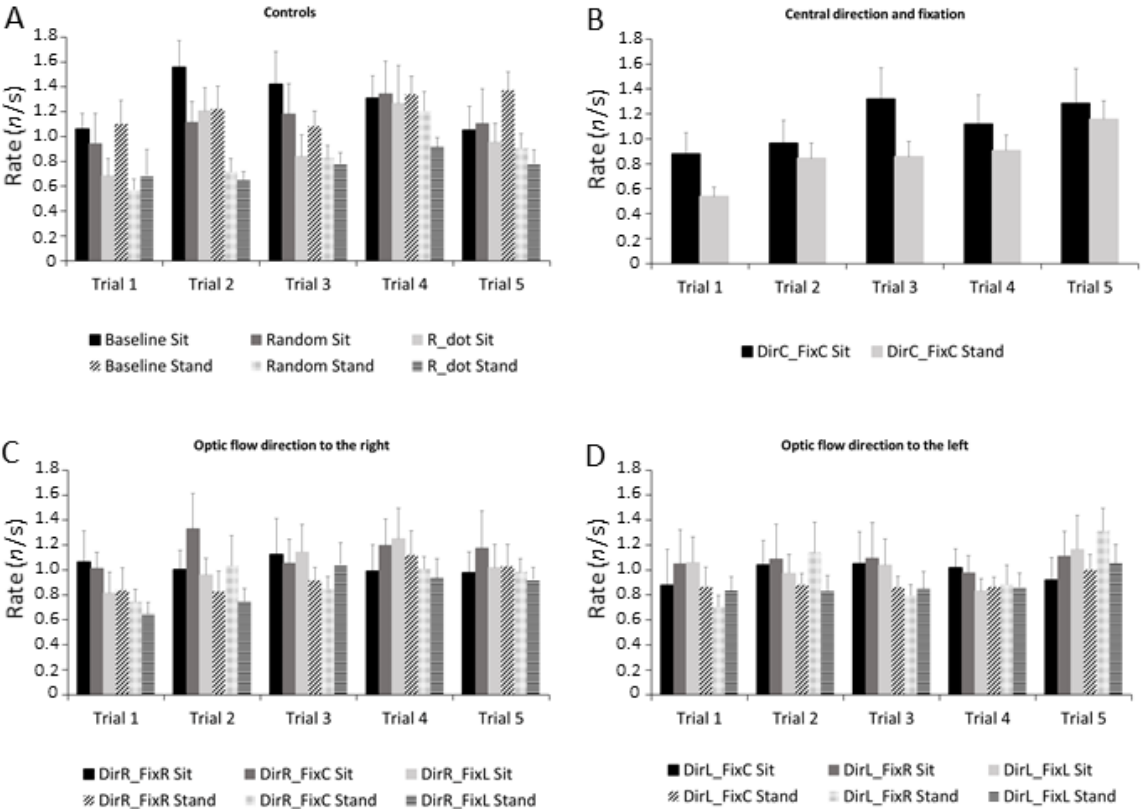
Figure 7. Frequency histograms of microsaccade rates in all stimuli across trials in both sitting and standing conditions. ( A ) Controls: Baseline, R_dot, Random. ( B ) Central direction and fixation: DirC-FixC. ( C ) Optic flow direction to the right: DirR-FixR, DirR-FixC, DirR-FixL. ( D ) Optic flow direction to the left: DirL-FixR, DirL-FixC, DirL-FixL. Sitting condition is reported in black, standing condition in grey. Data are reported as mean ± SE. Conventions are as in Figure 1.